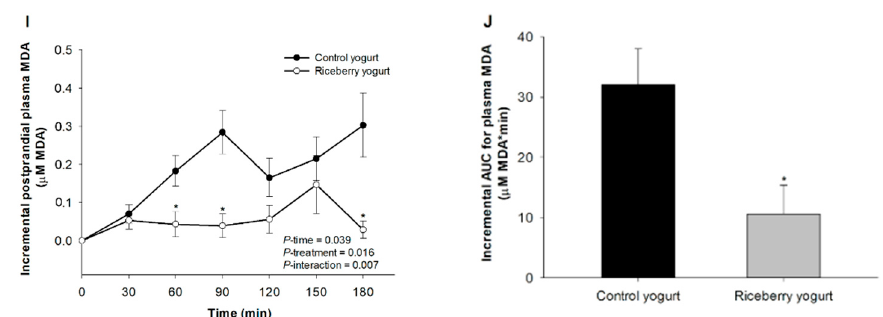
Figure 3. Incremental changes in postprandial plasma: ferric reducing ability of plasma (FRAP) ( A ); Trolox equivalent antioxidant capacity (TEAC) ( C ); oxygen radical absorbance capacity (ORAC) ( E ); thiol ( G ); and malondialdehyde concentration (MDA) ( I ). The incremental area under the curve (iAUC) for postprandial plasma: FRAP ( B ); TEAC ( D ); ORAC ( F ); thiol ( H ); and MDA ( J ) in healthy participants after consuming either the control yogurt ( ● ) or riceberry rice yogurt ( ○ ). Data are presented as mean ± SEM, n = 19. * p < 0.05 compared to the control yogurt.